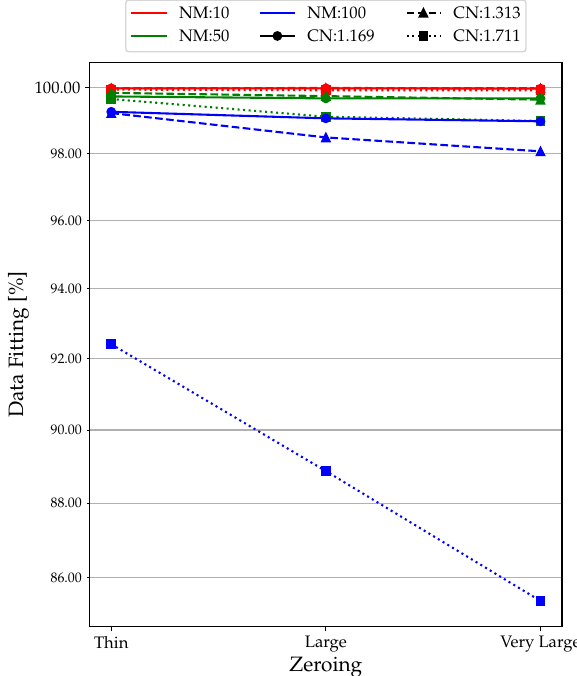
Figure 13. Zeroing analysis: data fitting results.